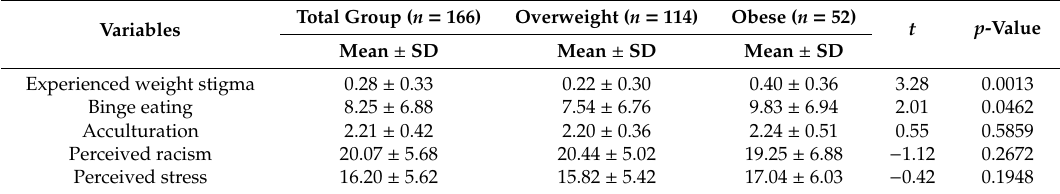
Table 2. Descriptive statistics for experienced weight stigma, binge eating, acculturation, perceived racism, and perceived stress by the total sample and weight status.